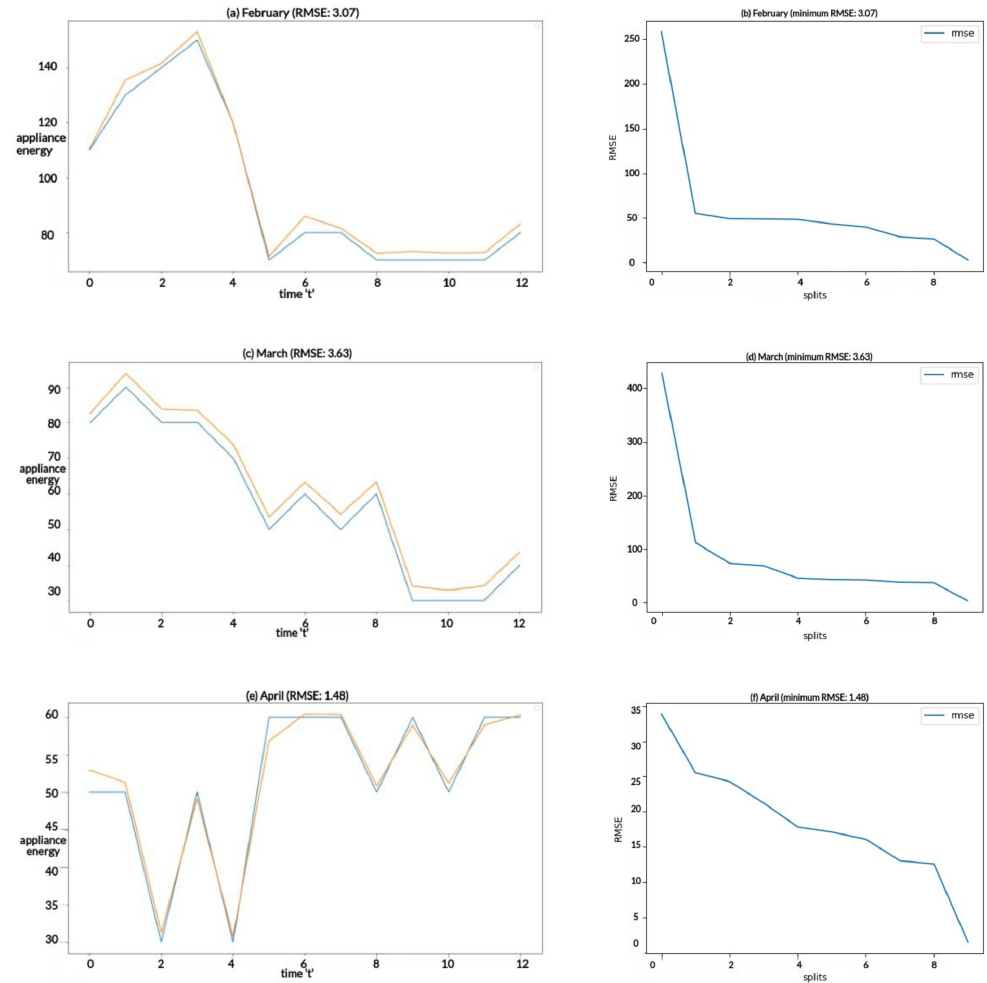
Figure 7. Appliance energy forecasts and RMSE score of the